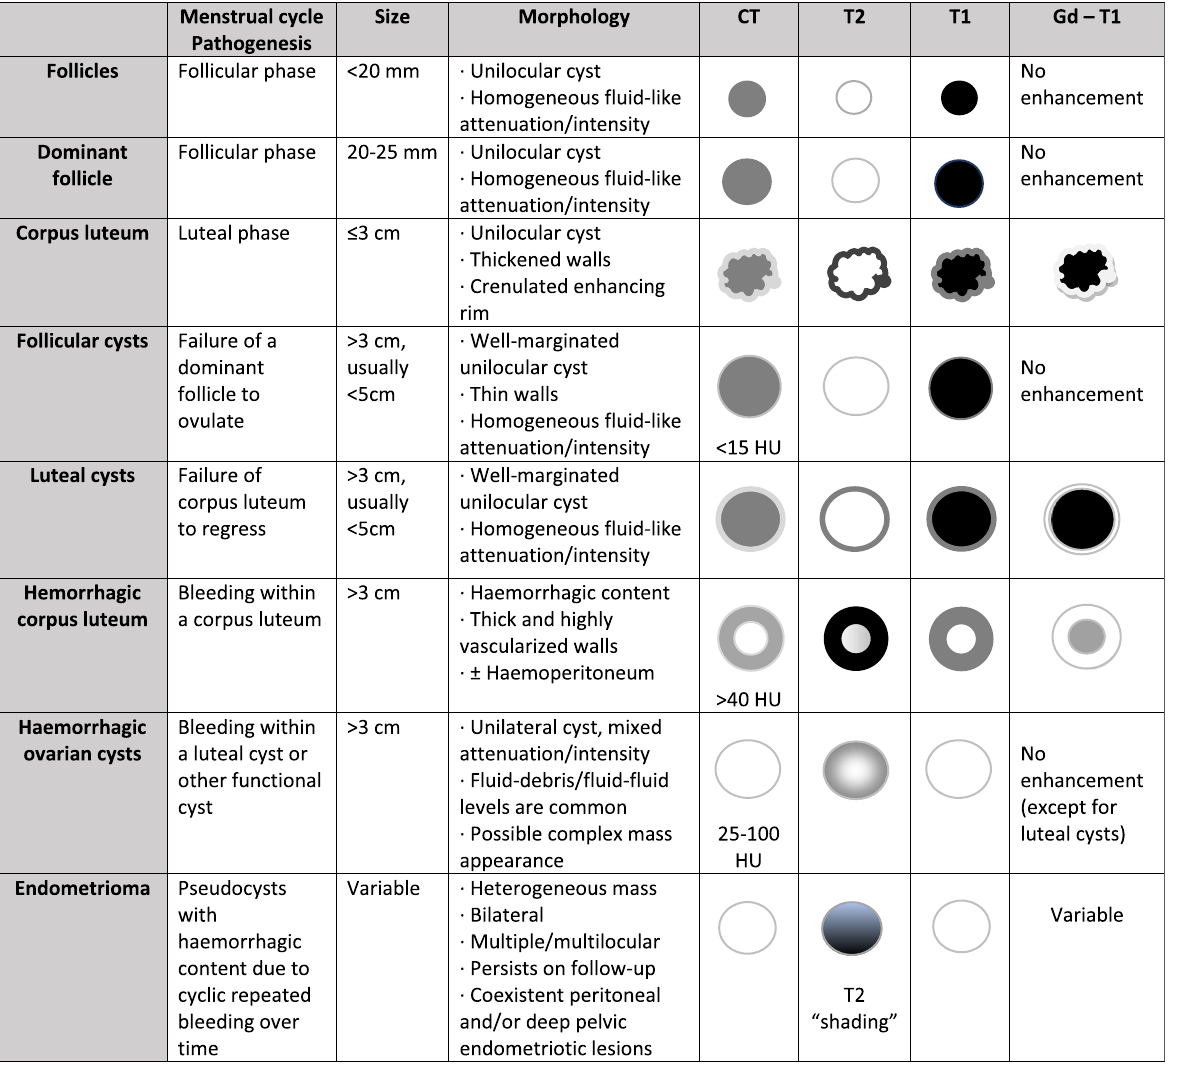
Tonolini et al. Insights into